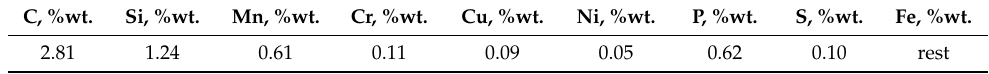
Table 2. Chemical composition of the metallic matrix: gray cast iron with flake graphite. C, %wt. Si, %wt. Mn, %wt. Cr, %wt. Cu, %wt. Ni, %wt. P, %wt. S, %wt. Fe, %wt. 2.81 rest